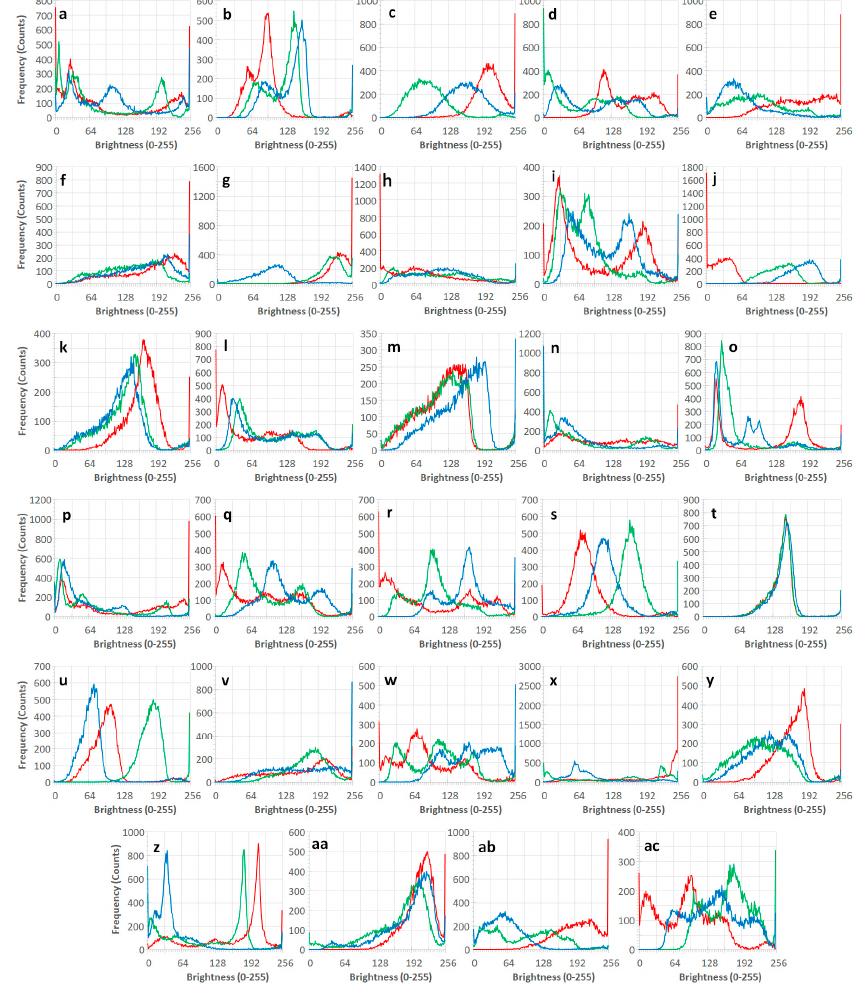
Figure 5. RGB intensity histograms of twenty-nine T-shirt images ( a – ac